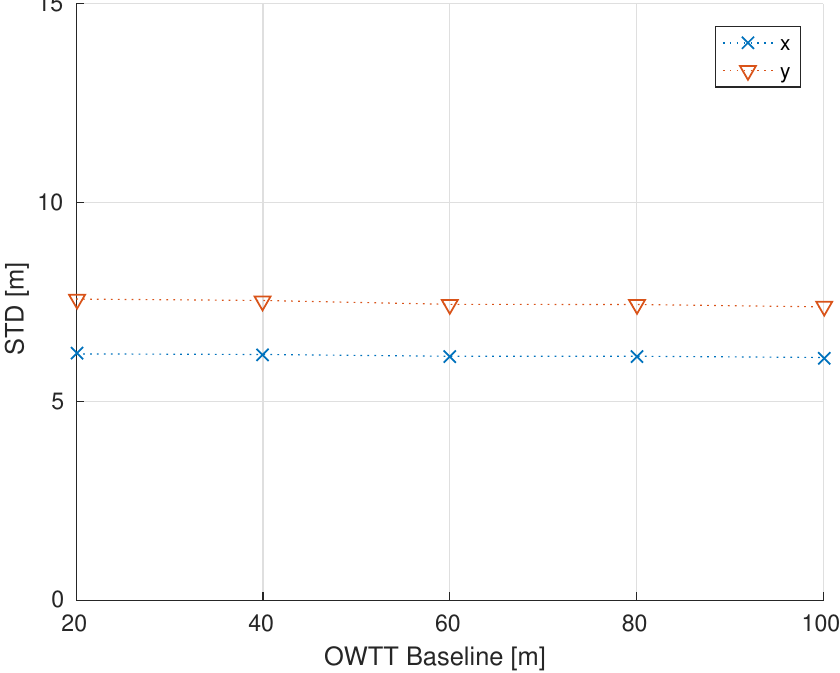
Figure 8. Ice-relative vehicle x − y position uncertainty averaged over the 7.7 km ice relative mission for varying OWTT baselines. A 500 m GNSS line configuration and constant 0.25 m/s and 2 deg/h linear and angular ice velocity were simulated. Similar to vehicle RMS position error, ice-relative vehicle position uncertainty appears insensitive to transducer